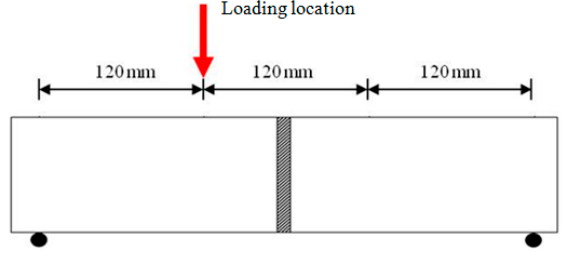
Figure 6. Eccentric 3-point bending test. Table 7. Test case notations.